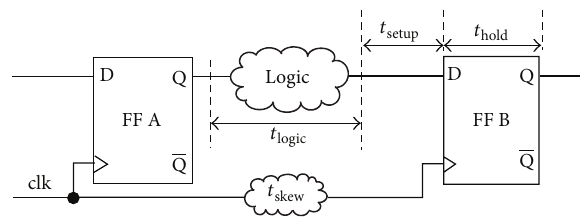
Figure 1: Flip-flop environment in a digital